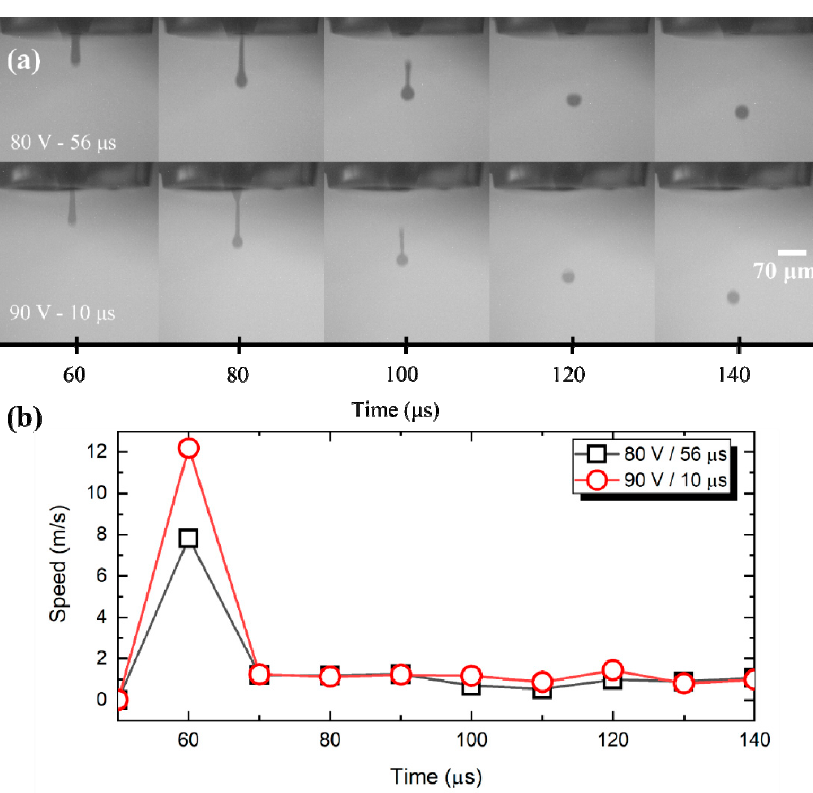
Figure 2. Droplet formation of graphene ink. ( a ) White labeled text indicates the inkjet settings, while the X axis corresponds to the delay after firing the piezoelectric element and the image acquisition; ( b ) calculated speed for graphene ink.